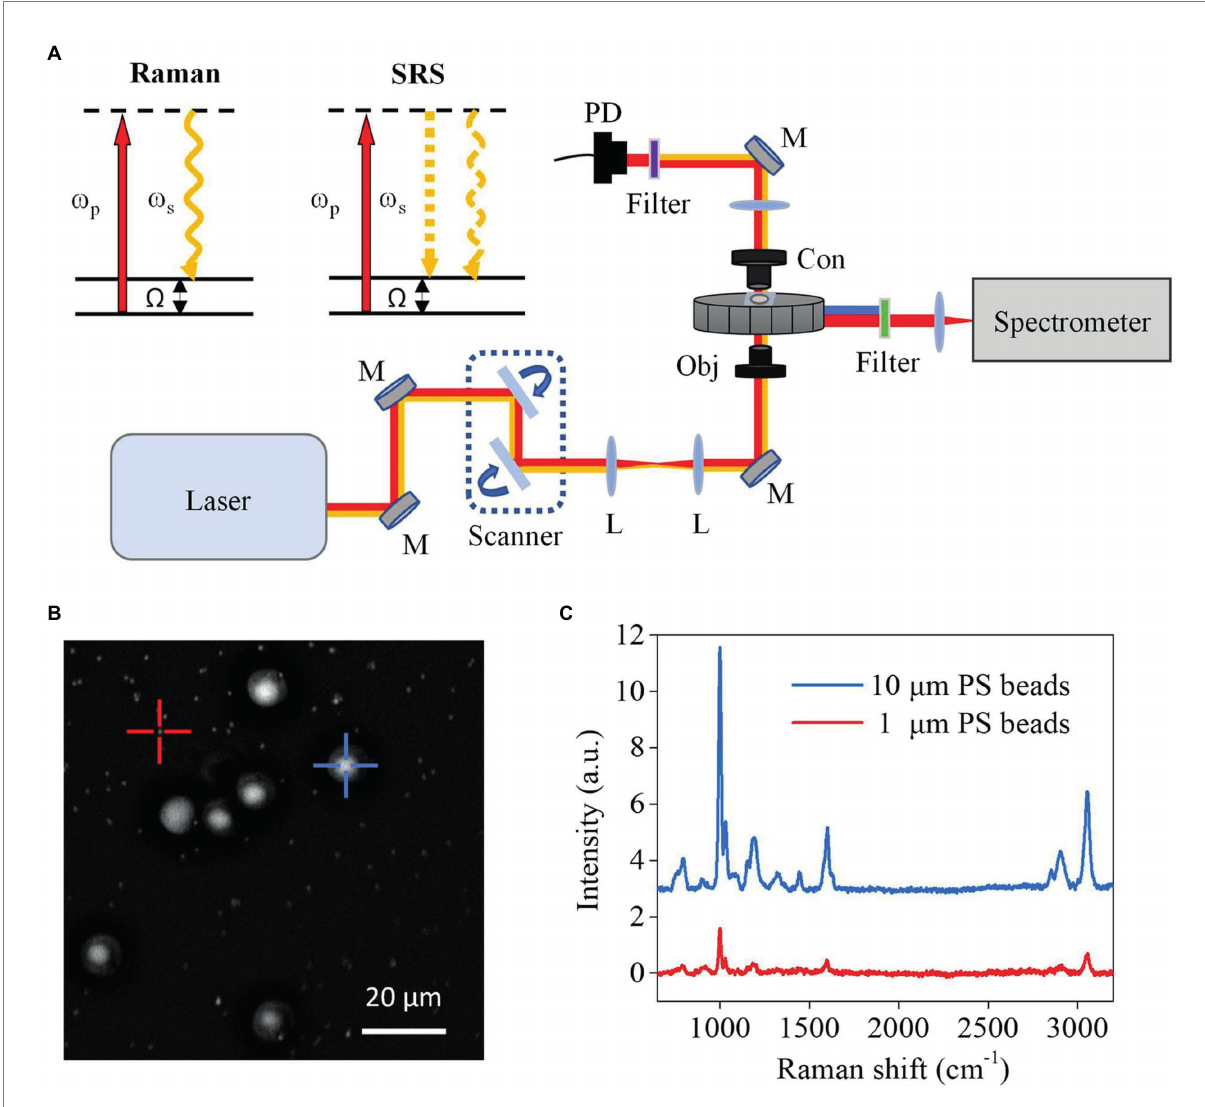
FIGURE 1 Schematic setup and performance of the CRM system. (A) Schematic setup and diagrams of spontaneous Raman and SRS microscopy. ω p , pump beam; ω s , Stokes beam; Ω , Raman-active molecular vibration; L, lens; M, mirror; Obj, objective; Con, condenser; PD, photodiode. (B) SRS image of a mixture of PS beads with 1 μ m and 10 μ m diameters. (C) Raman spectra obtained from 1 μ m and 10 μ m beads in (B) ,